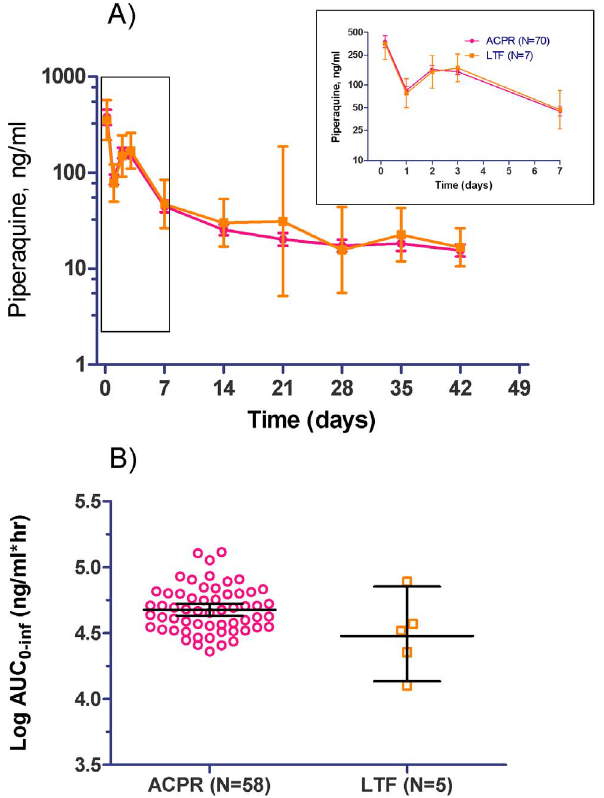
Figure 2. Comparison of plasma piperaquine levels between ACPR and recrudescent patients. (A) Concentration–time profiles (geometric mean concentrations with 95% CI) for ACPR and recrudes- cent groups. There were no statistically significant differences beween groups at any timepoint. (B) AUC 0- ‘ (2 compartment analysis) in ACPR and LTF groups. Black lines represent geomean with 95%CI. Note that AUC could not be calculated in 4 and 2 patients in the ACPR and LTF groups, respectively due to limited timepoints (only 3) in the terminal phase.